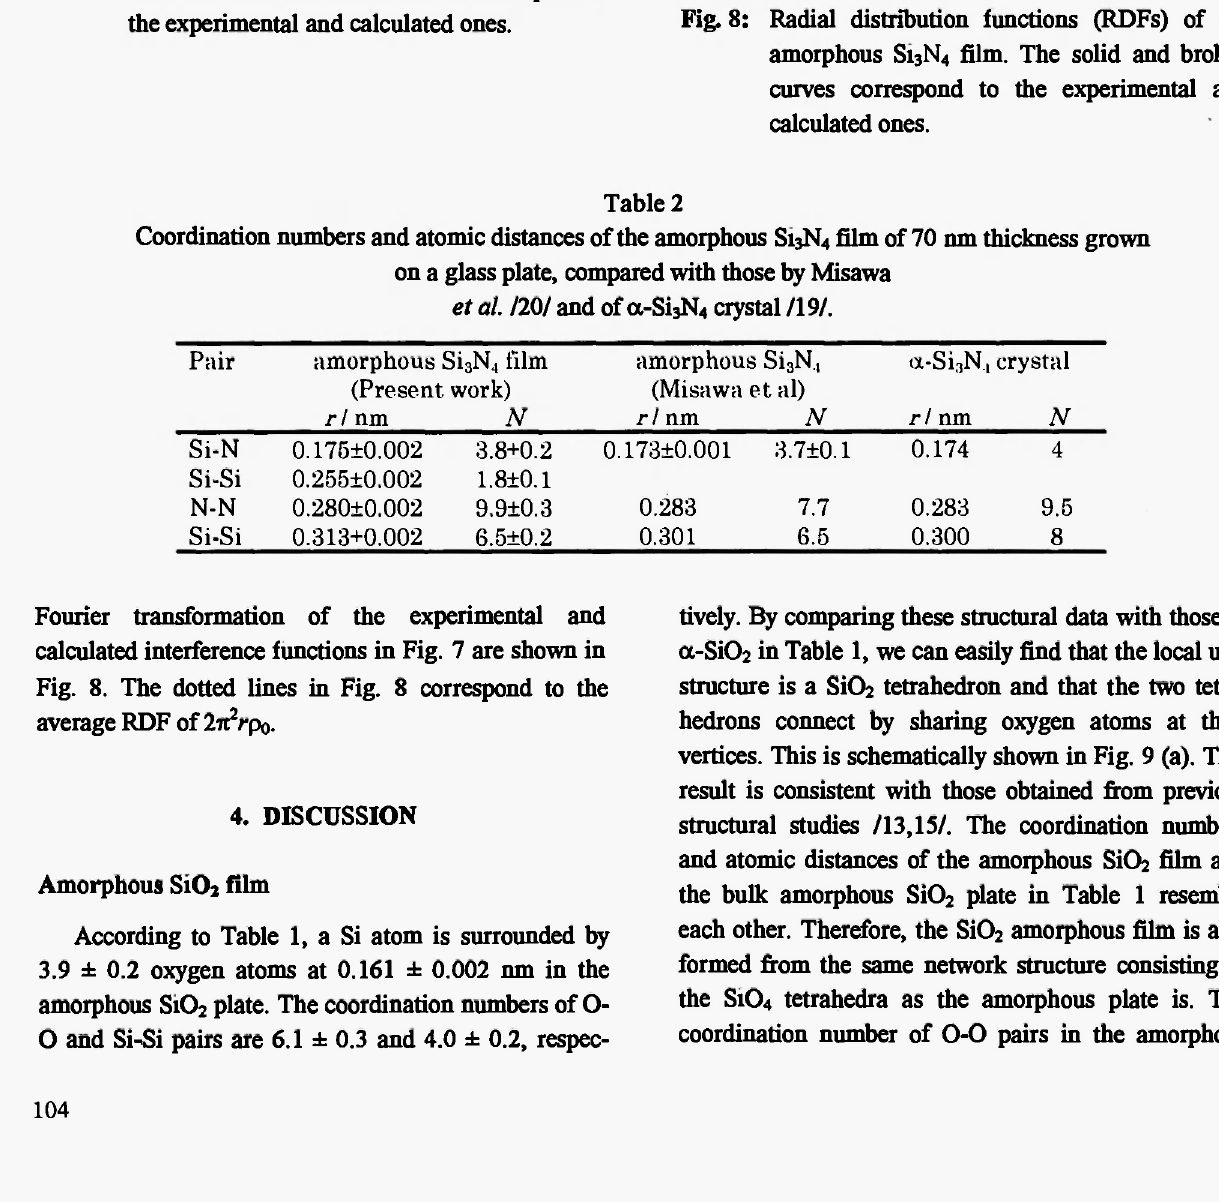
r nm amorphous S13N4 film. The solid and broken curves correspond to the experimental and calculated